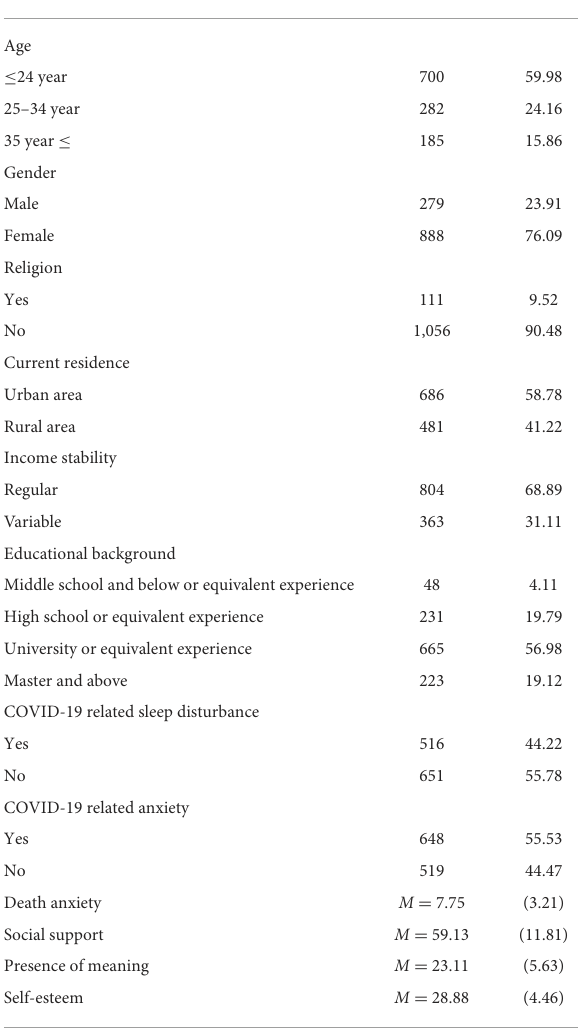
TABLE 1 Descriptive statistics for demographic characteristics, death anxiety, presence of meaning, search meaning, self-esteem, social support, COVID-19 related sleep disturbance, and COVID-19 related anxiety ( N =